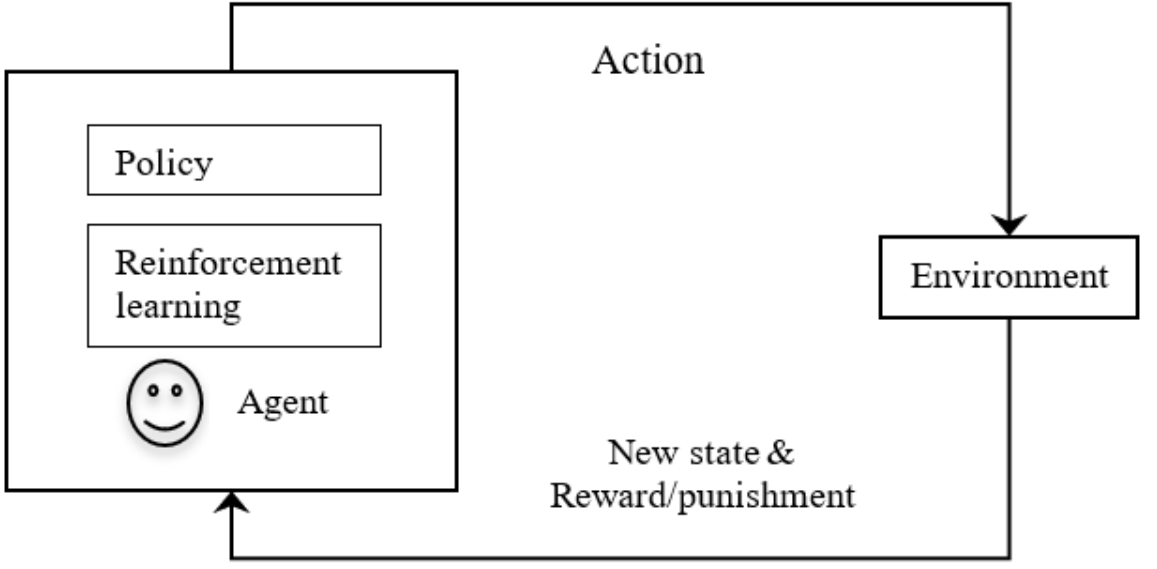
Figure 5. Trial-and-error-based reinforcement learning in AI.